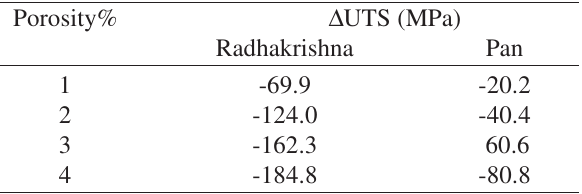
Table 1. Detrimental effect on tensile strength obtained by Pan and Radhakrishna’s equation for 356 aluminum alloy.